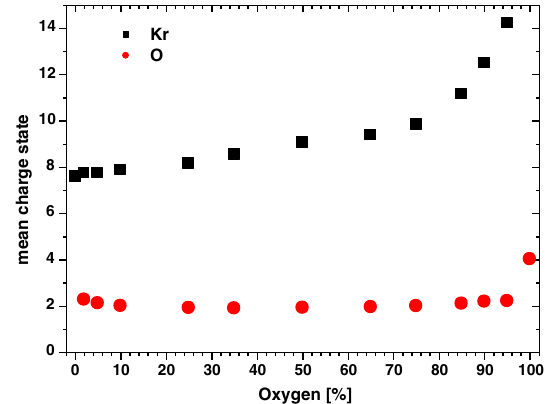
FIG. 5. Mean charge state of the krypton and oxygen ions inside the ECR volume for different oxygen